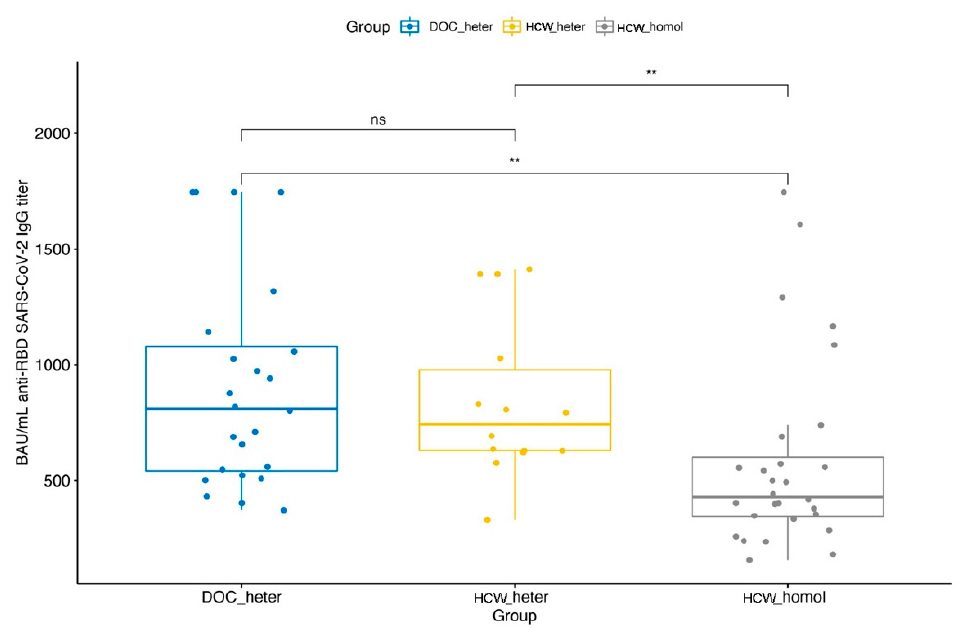
Figure 2. Pairwise comparisons of antibodies’ responses after the booster dose of vaccination between the study groups. ** significant at p -level < 0.05 Table 2. Raw and transformed Log2 values of antibody responses in DOC and HCW groups.